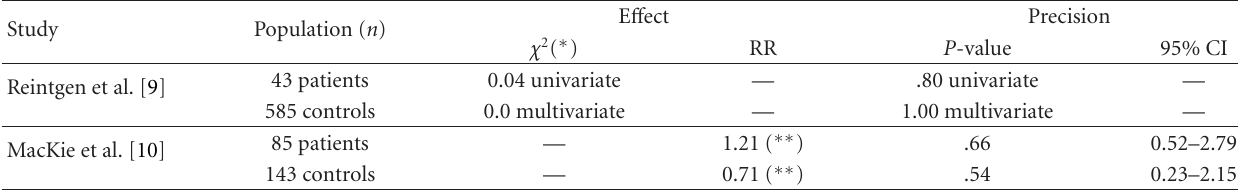
Table 3: Influence of pregnancy on recurrence of cutaneous malignant melanoma in